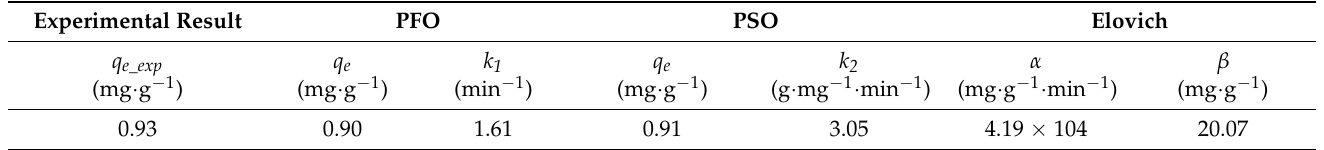
Table 3. Adsorption kinetics statistics obtained for the treatment under optimized conditions. PFO Table 2. Adsorption kinetics parameters obtained for the treatment under optimized conditions.